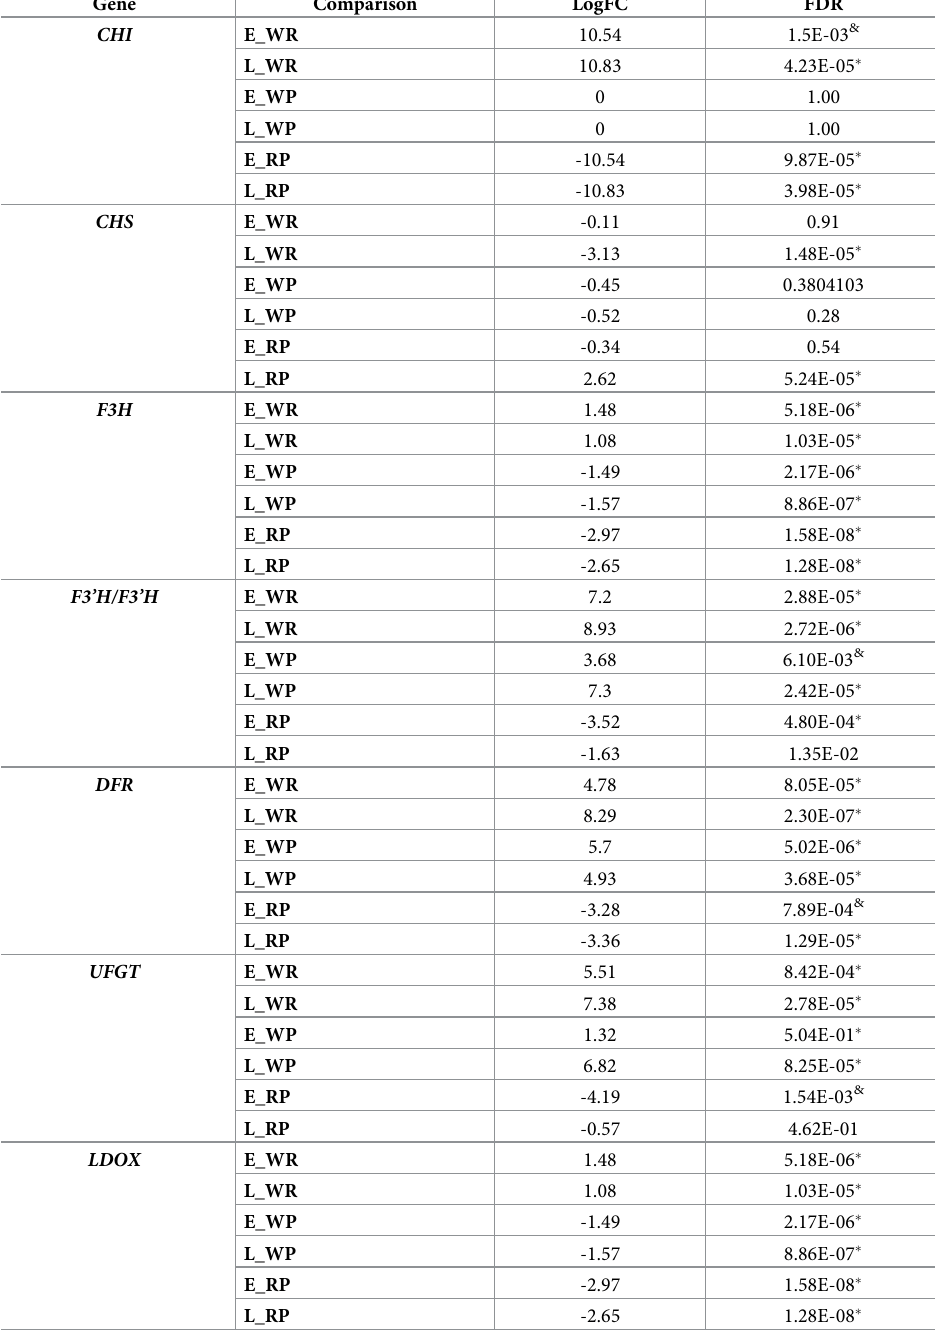
Table 2. Differential expression of genes in the anthocyanin pathway between White and Red (WR), White and Purple (WP), and Red and Purple (RP) at early (E) or late (L)